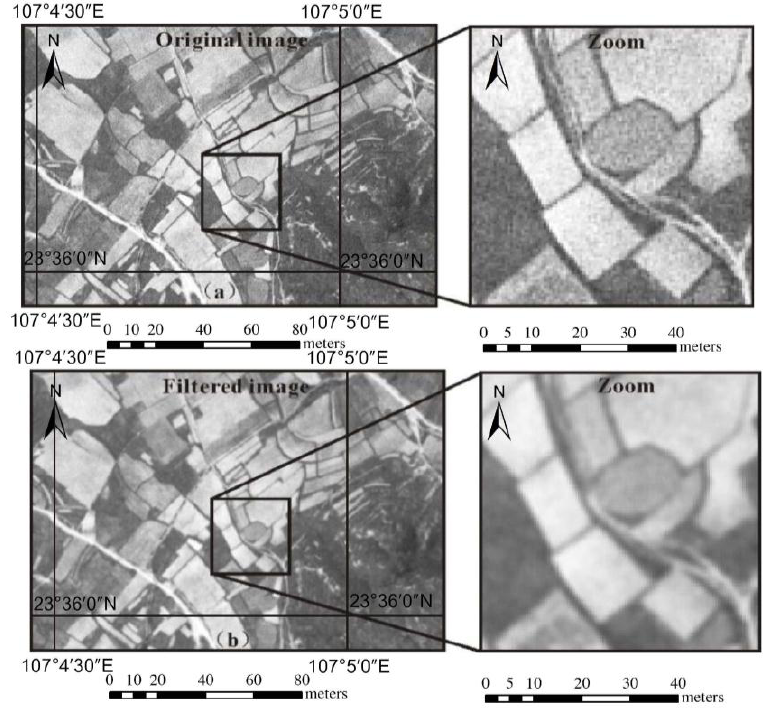
Figure 6. The results of noise removing: ( a ) The original image, and ( b ) The filtered image.